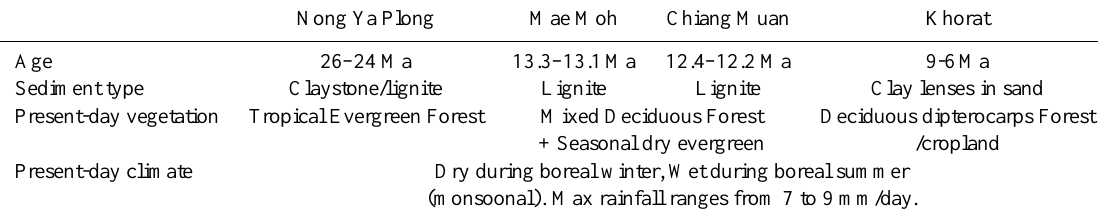
Table 1. Age, lithology, and present-day environmental characteristics of the four sites studied.